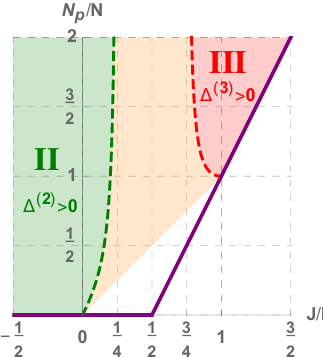
exist. In the green region, which is j(cid:0)i